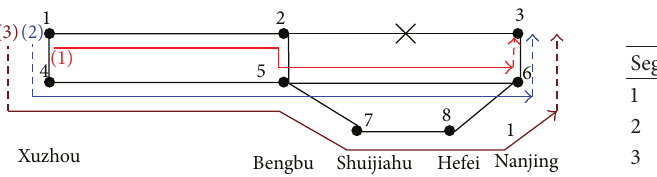
Figure 3: Paths between Xuzhou and Nanjing in an emergency. Table 1: Available paths from Xuzhou to Nanjing (by 𝐶 -enough plan).